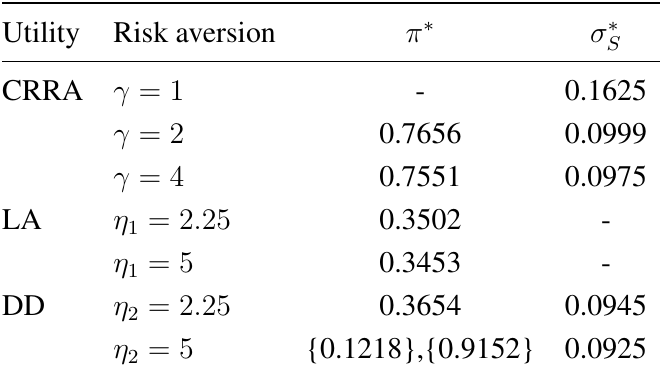
Table 2. Different indifference parameter